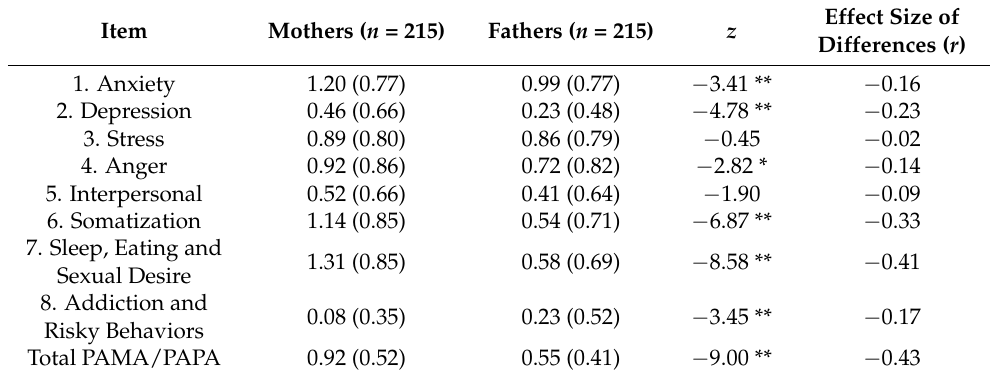
Table 4. Descriptive statistics and differences between maternal and paternal scores on